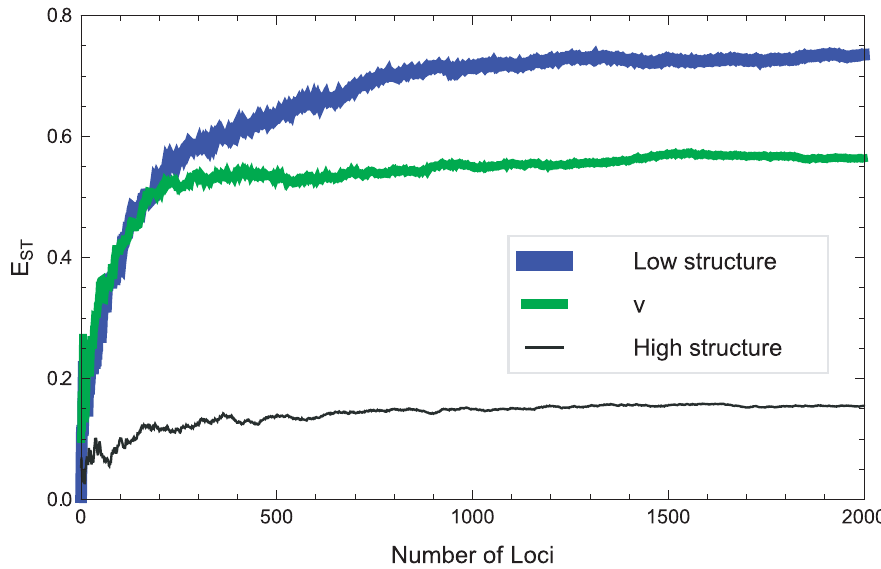
Fig 11. A numerical simulation of a model for E ST for two structured populations (with F ST = 0.05). E ST was computed using the formulation in Eq (2) of Materials and Methods .